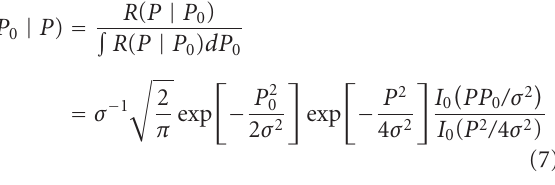
√ 2, the posterior